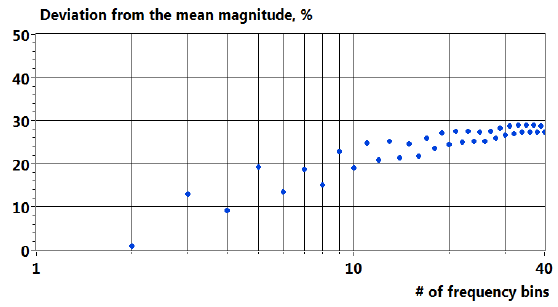
Fig.7: Relative deviation of RMS magnitudes of the frequency components from their mean values of the linear sinusoidal chirp with normalized frequencies in the range from 10 to